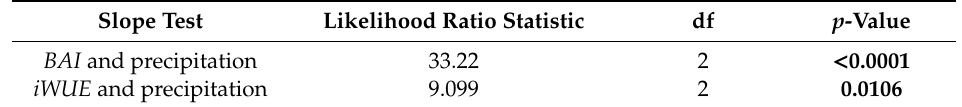
Figure 5. Relationships of 10-year moving average data over the past 61 years between ( a ) BAI and precipitation ( n = 27, 28, and 27), and ( b ) iWUE and precipitation ( n = 3, 3, and 3), for low, medium, and high competition-level trees, using standardized major axis (SMA) regression. Table 3. Slope tests of the standardized major axis (SMA) regressions shown in Figure 5. Slope Test Likelihood Ratio Statistic df p -Value BAI and precipitation 33.22 2 < 0.0001 iWUE and precipitation 9.099 2 0.0106